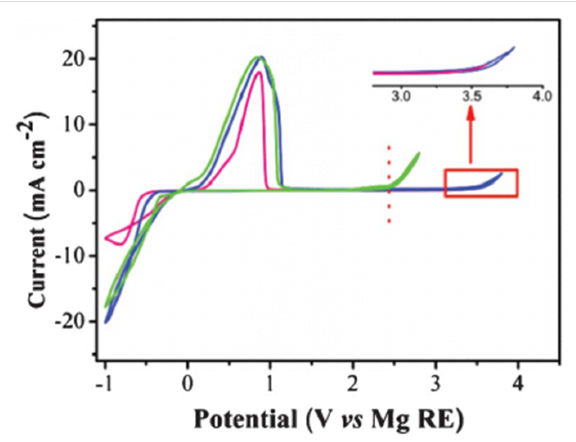
Figure 5: Cyclic voltammograms of the Mg deposition/dissolution in 0.25 M THF solution containing as-prepared (HMDS) 2 Mg–2AlCl 3 (blue) and redissolved crystals [Mg 2 (µ-Cl) 3· 6THF][HMDSAlCl 3 ]·THF (pink). The as-prepared [(iPr 2 N) 2 Mg–2AlCl 3 ] is also shown (green). Reproduced with permission from [32]. Copyright 2013 The Royal Society of